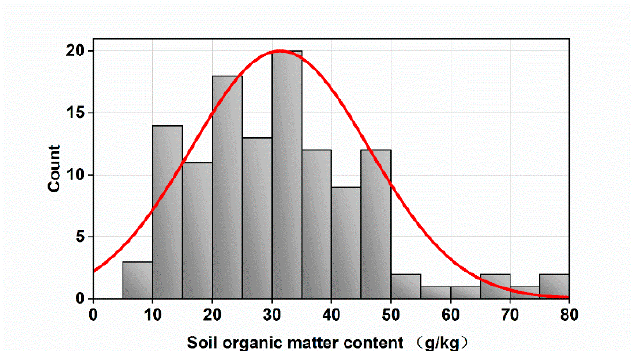
Figure 2. Frequency histogram of SOM content.